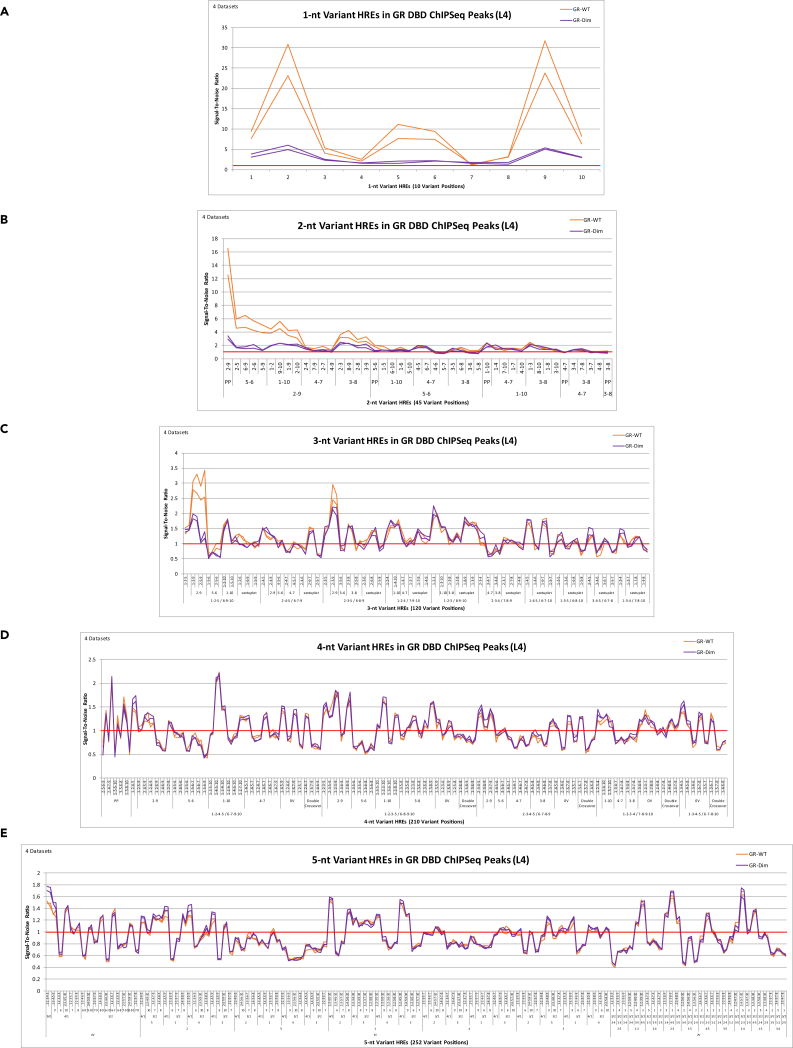
(S/N) Analysis of 1- to 5-nt Variant HRE DNA Elements in GR and GR-Dim ChIPSeq Peaks(A–E) (S/N) analysis of 1- to 5-nt variant HRE DNA elements (displayed by variant position) in GR (GR-WT-pred-6am-1) (34,758 peaks, 151-nt peak length) (GR-WT-pred-6am-2) (23,742 peaks, 142-nt peak length) ChIP-Seq peaks and GR-Dim (GR-Dim-pred-6am-1) (22,130 peaks, 163-nt peak length) (GR-Dim-pred-6am-2) (34,966 peaks, 148-nt peak length) ChIPSeq peaks. Upper and lower one-tailed Poisson significance thresholds at p < 0.001: (A) 0.00, 2.60; 0.00, 3.11 [GR-WT] 0.00, 2.91; 0.00, 2.63 [GR-Dim]; (B) 0.58, 1.49; 0.48, 1.62 [GR-WT] 0.48, 1.61; 0.56, 1.49 [GR-Dim]; (C) 0.75, 1.27; 0.69, 1.35 [GR-WT] 0.70, 1.34; 0.74, 1.28 [GR-Dim]; (D) 0.85, 1.16; 0.81, 1.20 [GR-WT] 0.82, 1.19; 0.85, 1.16 [GR-Dim]; (E) 0.91, 1.09; 0.89, 1.11 [GR-WT] 0.89, 1.11; 0.91, 1.09 [GR-Dim].